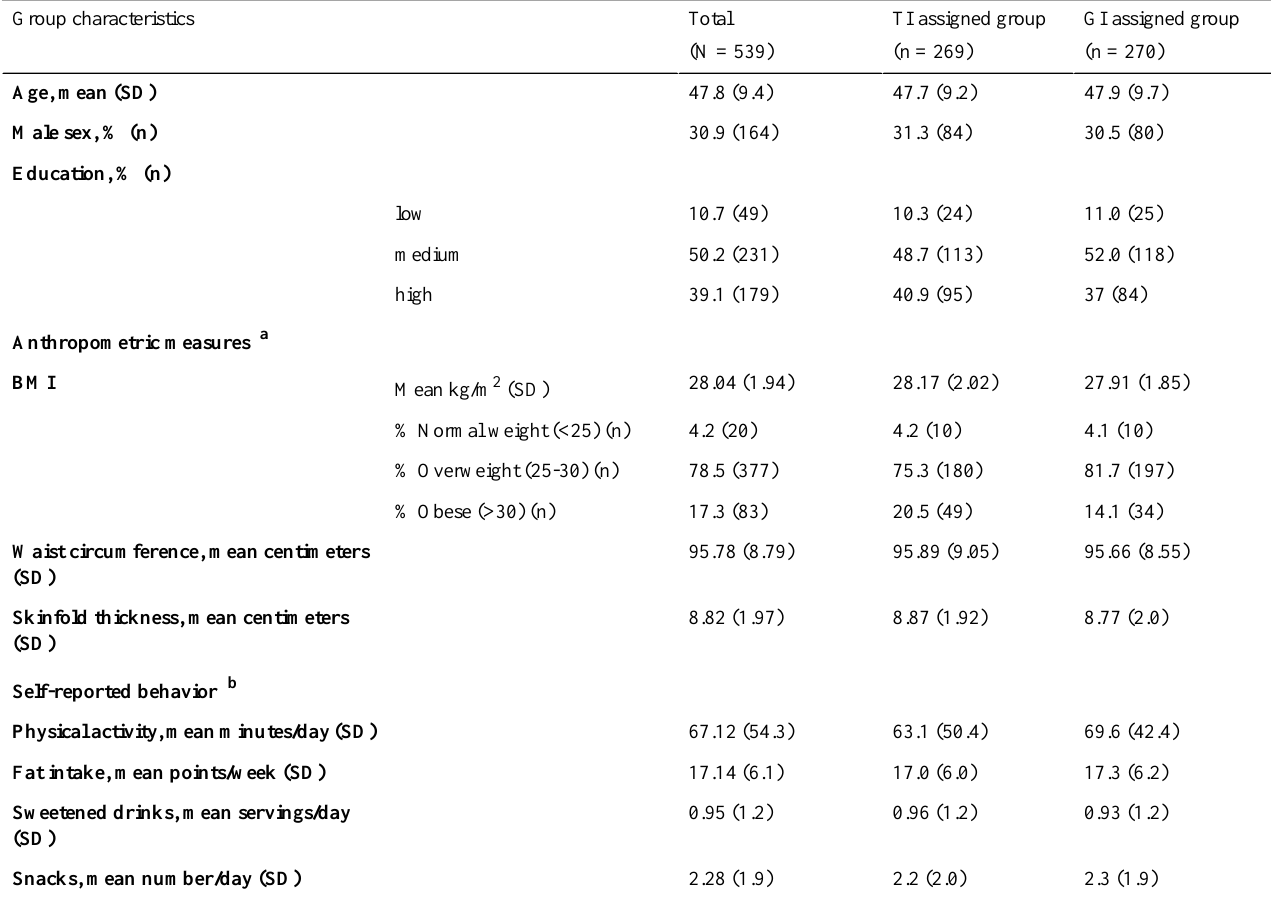
Table 1. Participant characteristics at baseline.